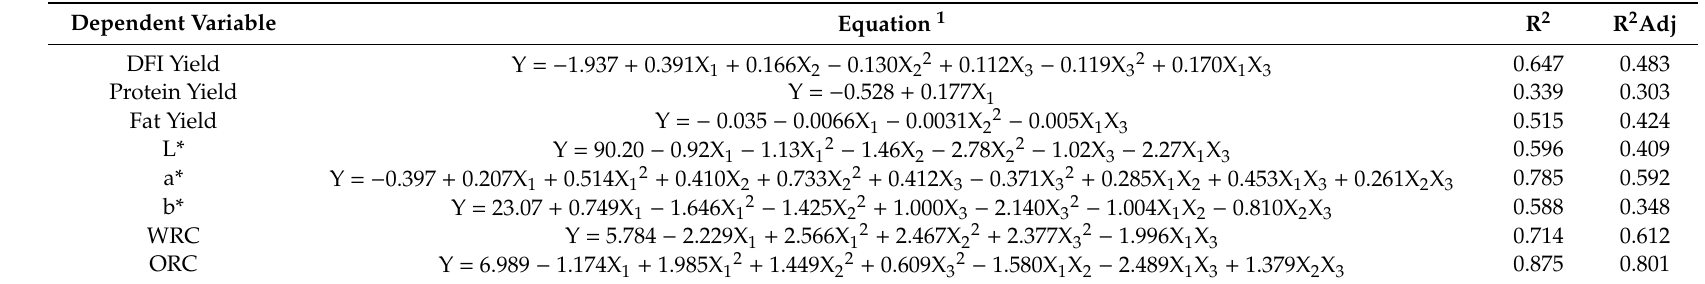
Table A1. Regression equation coe ffi cients for response parameters of mushrooms